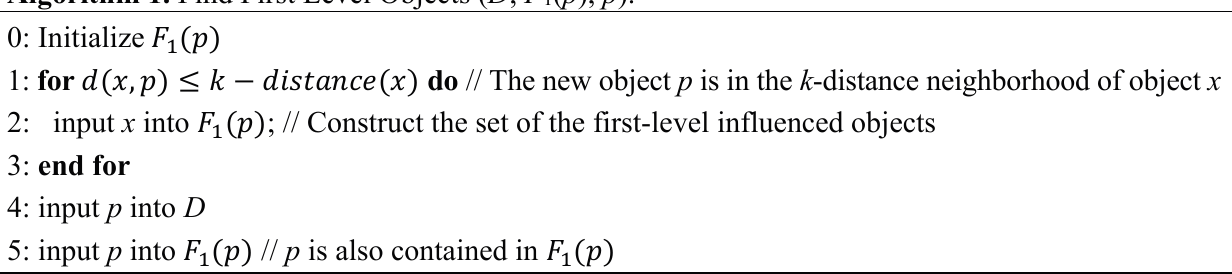
Algorithm 1. Find First Level Objects ( D , F 1 ( p ), p ).